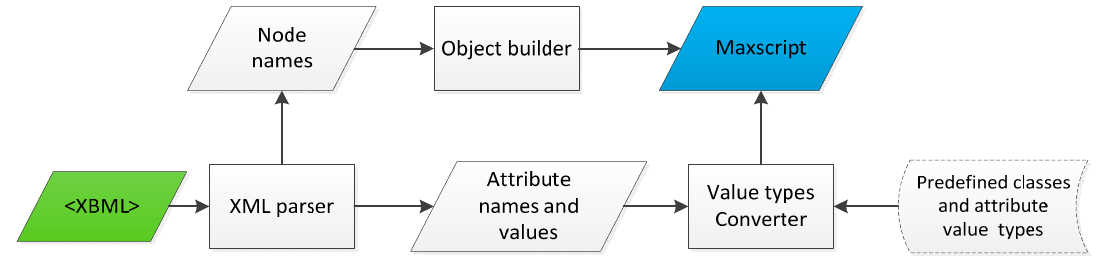
Figure 14. Flowchart of the XBML parser.